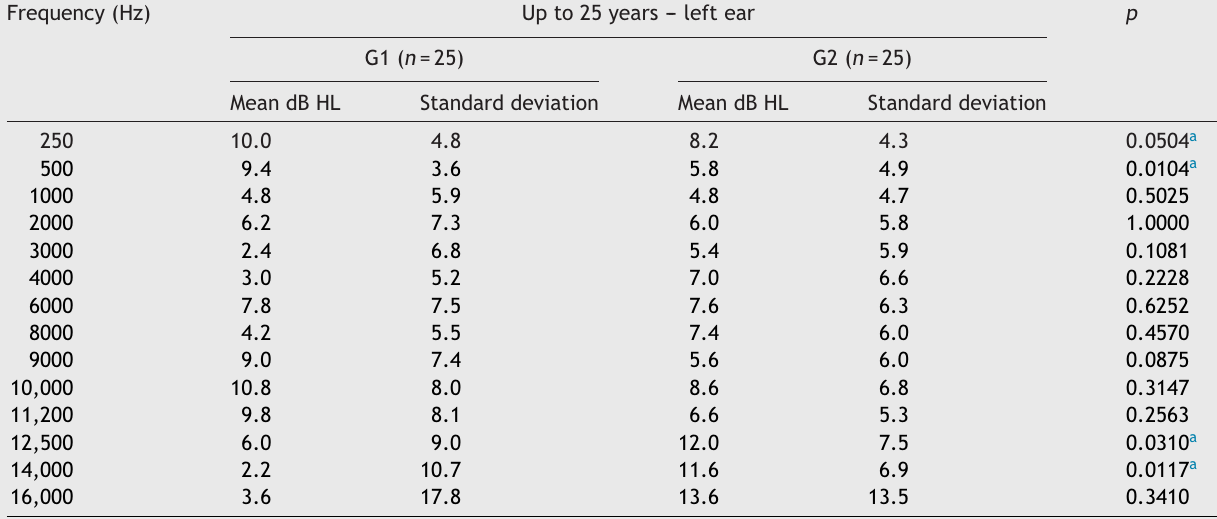
Mean pure-tone air-conduction thresholds in the left ear, by frequency, for age up to 25 years in groups G1 and G2 ( n =